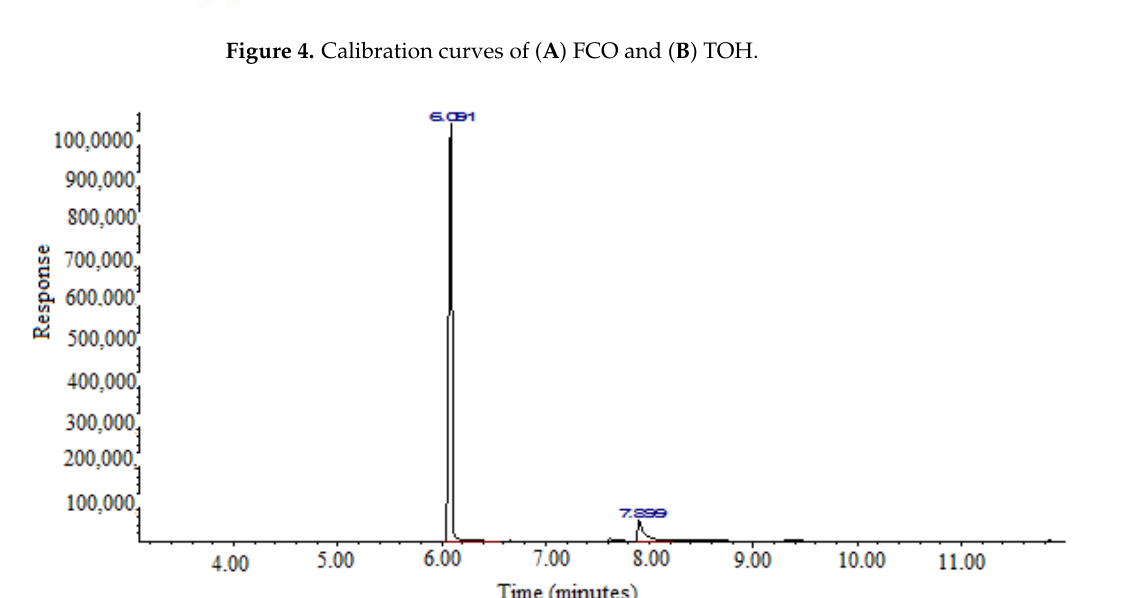
Figure 6. Overlaid GC-MS spectra of standard FCO and TOH at different concentrations. The accuracy of the proposed GC-MS approach for the simultaneous determination of FCO and TOH was computed as the percent of recovery, and findings are summarized in Table 2. Table 2. Determination of the accuracy of FCO and TOH for GC-MS approach (mean ± SD; n = 3). Conc. ( µg/g )